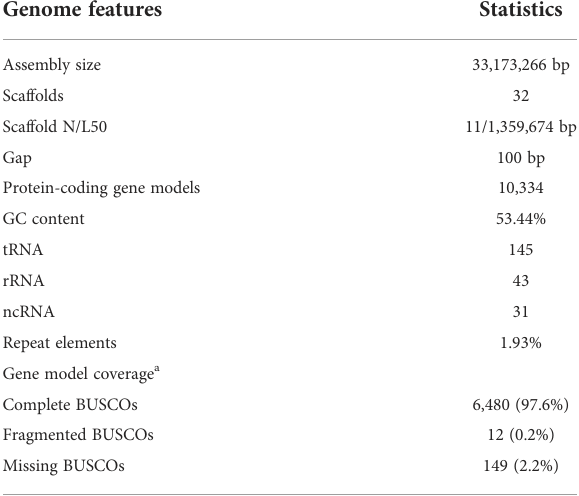
TABLE 1 The Didymella glomerata Pj-2 genome assembly